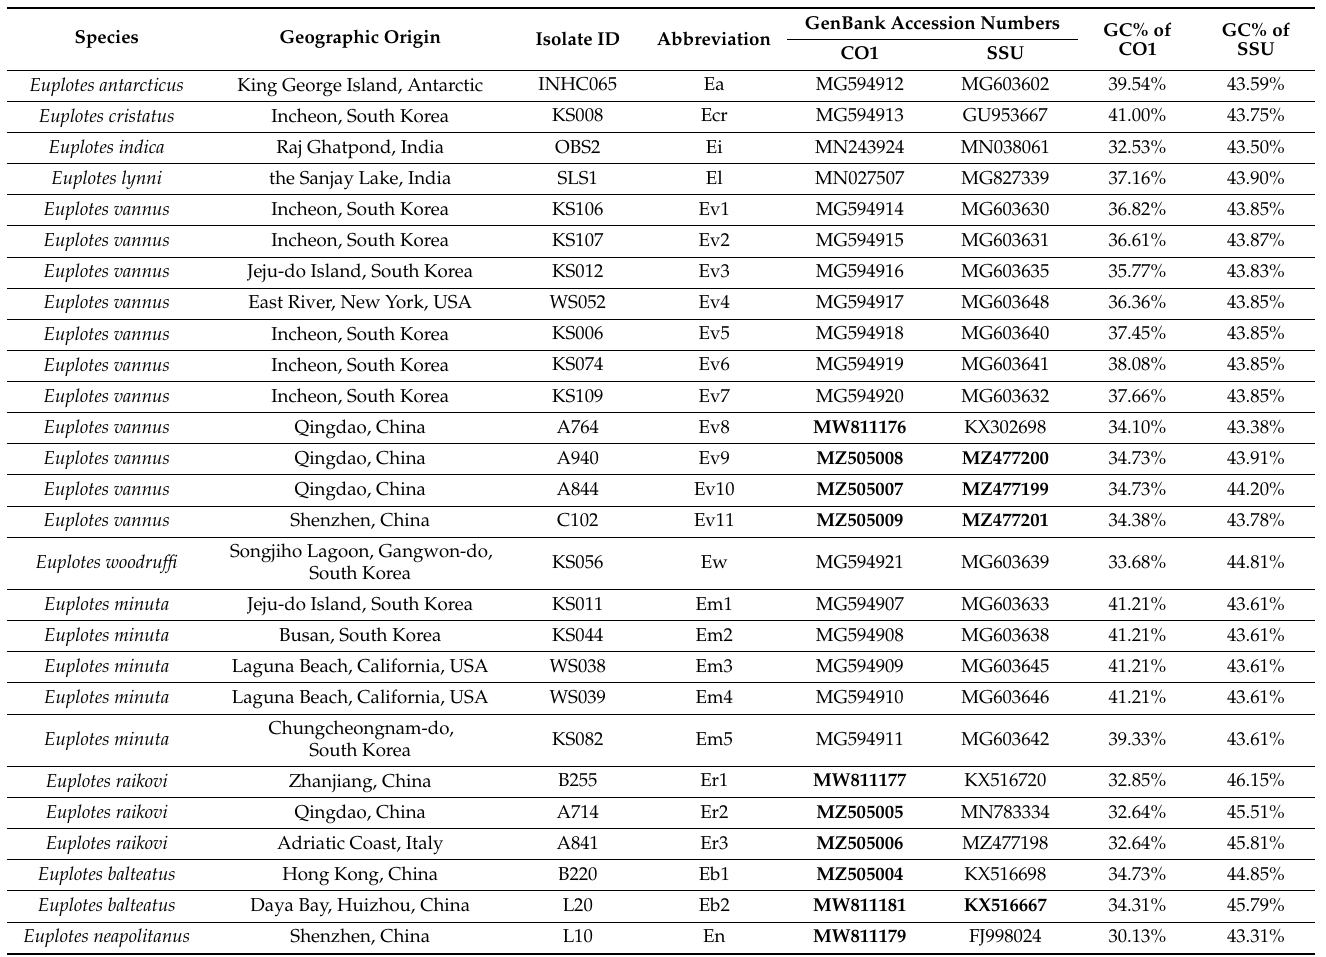
Table 1. Specifications of species with both SSU rDNA and partial CO1 gene sequence data from the same isolates analyzed in this study (new sequences in